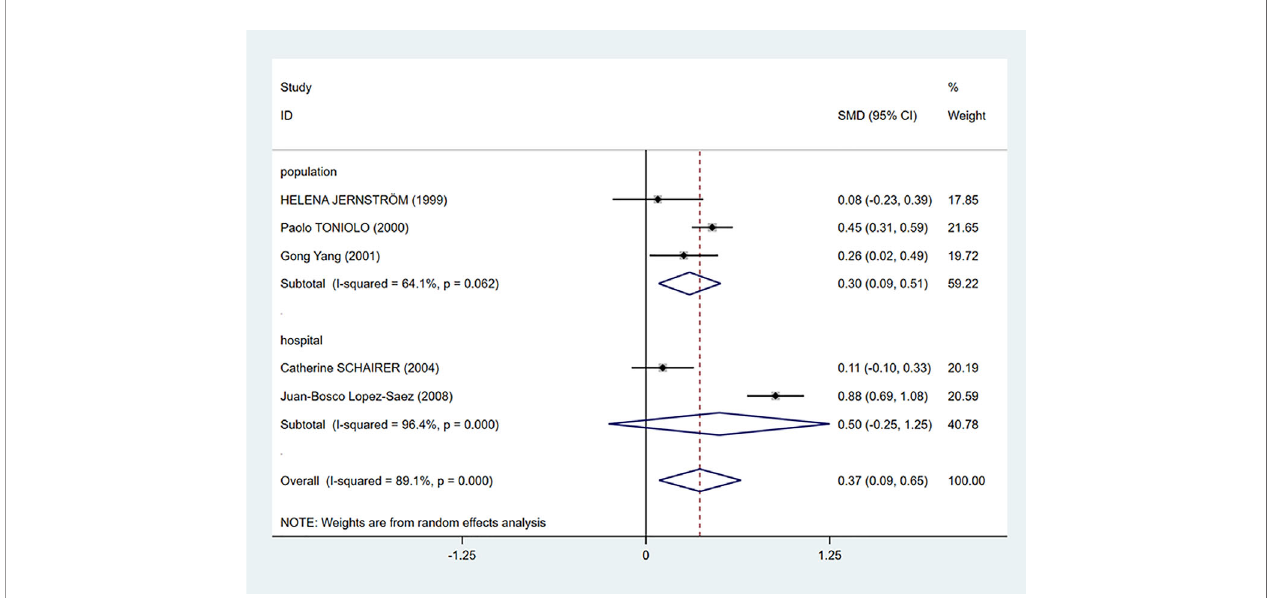
FIGURE 3 | Subgroup analysis of the association between C-peptide and breast cancer in different control sources. The size of the square box is proportional to the weight that each study contributes in the meta-analysis. The overall estimate and CI are marked by a diamond. Summary estimates were analyzed using a random-effects model. C-peptide levels are positively associated with breast cancer risk in population-based control group. No association is presented in hospital- based control group.